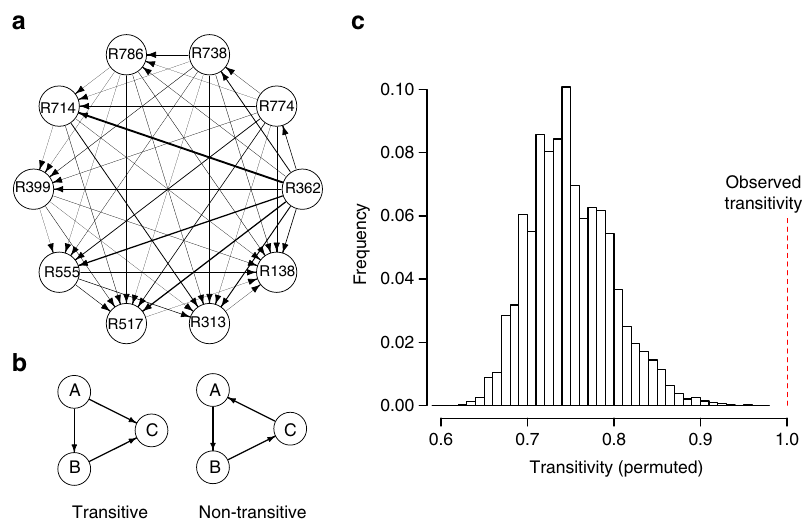
Figure 1 | Male D. melanogaster display transitive mate choice. ( a ) Mate choice network for Canton-S males, combining two independent replicates. More attractive lines (a line that received more than half of the matings in any pairwise competition) point to less attractive lines. The width of a line is proportional to the mating skew for each pairwise interaction. Absent arrows (for example, R517 versus R313) denote ties between two lines. Line number (for example, R362) corresponds to DGRP ID. ( b ) Examples of transitive and non-transitive triads. The overall transitivity of a network, t tri , is calculated as the proportion of transitive triads in the full network. ( c ) Transitivity scores from 100,000 permutations of mate choice data, used to calculate the significance of our mate choice network. On average, we expect that 75% of relationships would be transitive at random, as 6/8 possible relationships within a triad are transitive. Dashed line represents the observed transitivity score for Canton-S males, which is significantly greater than transitivity scores expected to be generated at random. The data used to generate panels ( a ) and ( c ) are the combined results of the separate mate choice assays using Canton-S males, while the statistics reported in the text were calculated for each assay